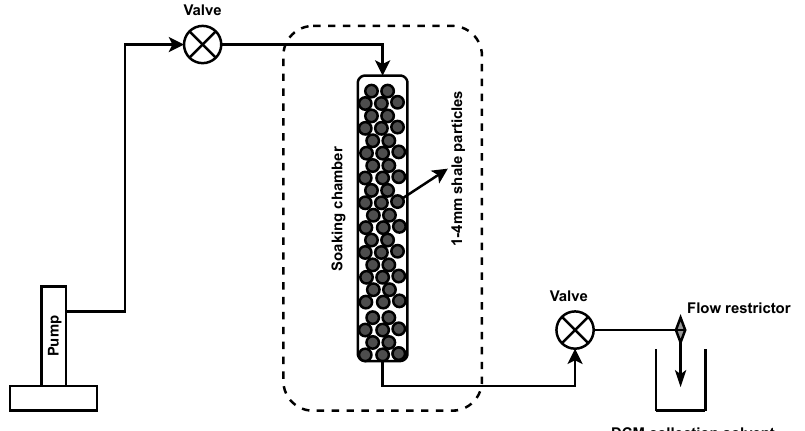
Figure 1. A schematic of the CO 2 extraction